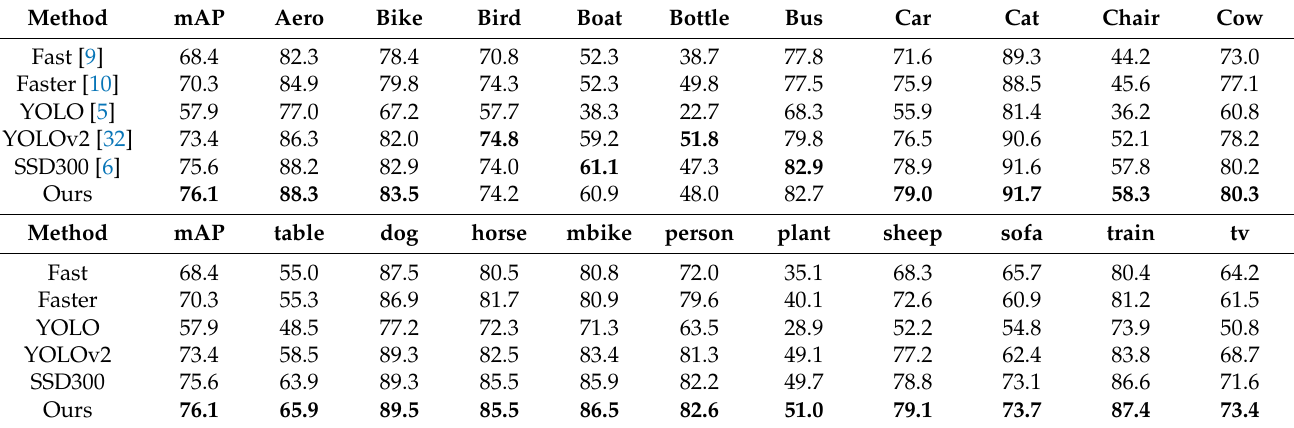
Table 6. The test detection result on PASCAL VOC2012.